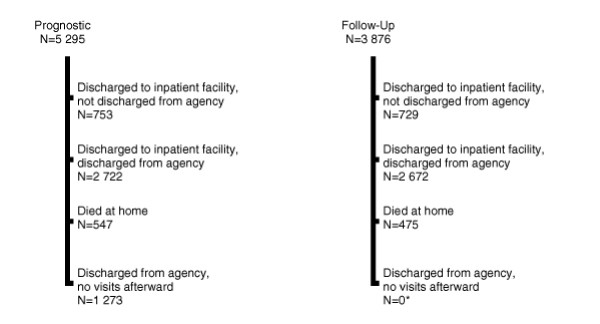
Excluded Episodes from Prognostic and Follow-Up Datasets. *CMS made coding changes in 2002 which accounts for this difference between the prognostic and follow-up datasets. Despite this difference, the datasets are similar with regard to included episodes.